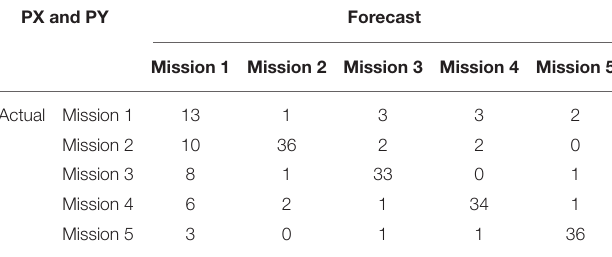
TABLE 3 | The discriminant classification results for PX and PY. PX and PY Forecast